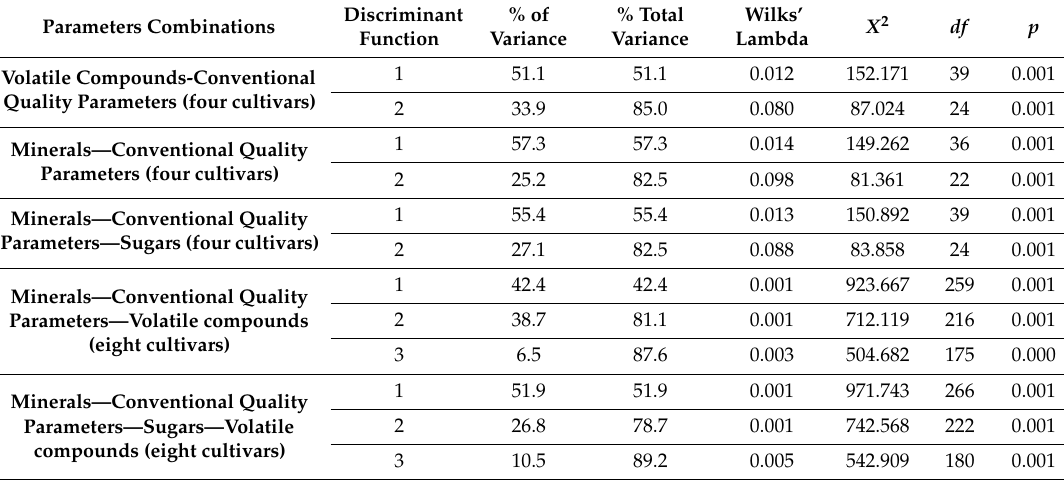
Table 4. Discriminant functions formed and MANOVA results for each function for parameter combinations